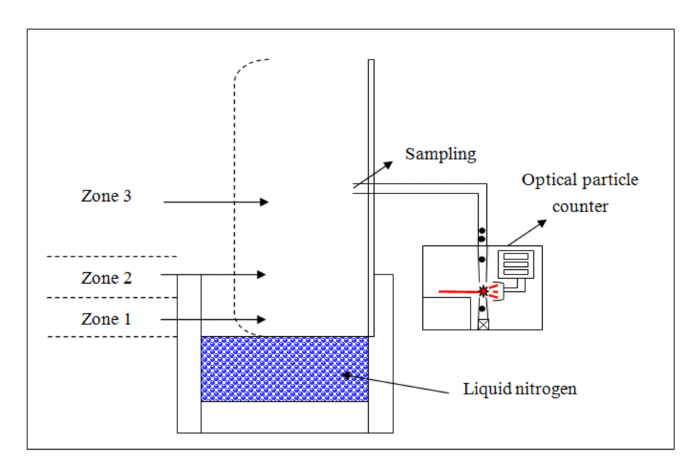
Figure 1. Schematic diagram of the experimental